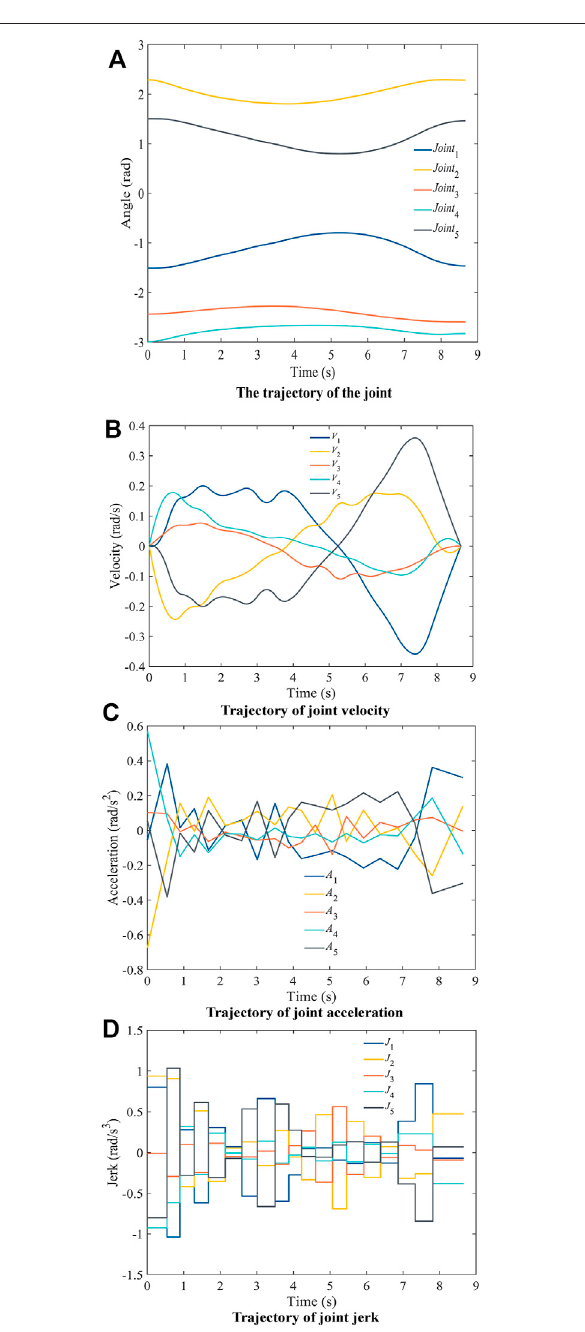
FIGURE 8 | Results of time-optimal trajectory planning for angle, velocity, acceleration and